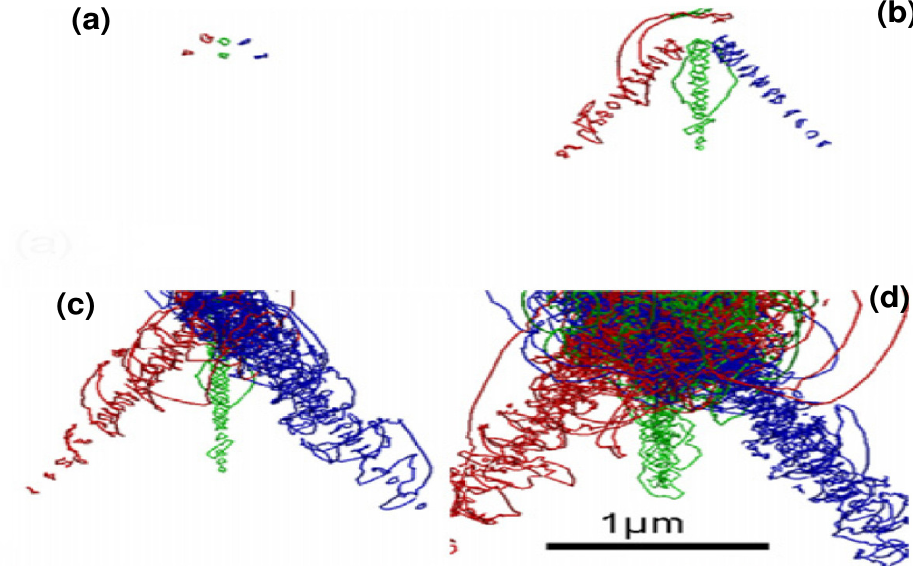
Figure 2. Load–displacement curve from DDD simulations using a spherical indenter of radius R = 150 nm. Region I is elastic, region II obtained from the DDD simulations is seen to follow the MD results and region III corresponds to the evolution beyond the MD region. Reproduced with permission from Chang et al. [26].